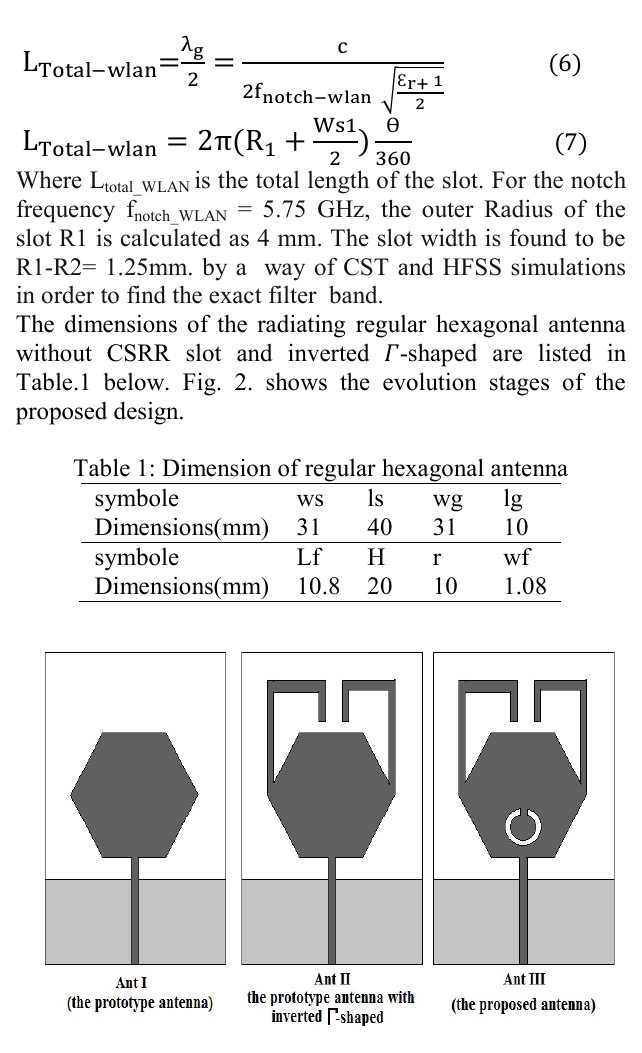
Figure 2: The structures of the prototype and proposed